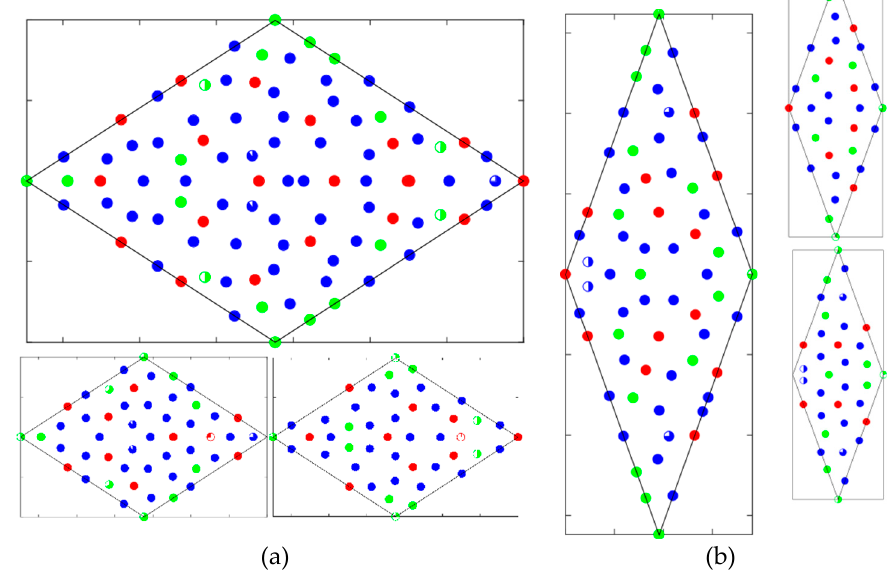
Figure 3. Decorations of structure units in the refined structure: ( a ) thick rhomb and ( b ) thin rhomb. Pairs of smaller rhombs represent decoration of unit tiles in different aperiodic planes along z -axis. Projections of decorated rhombs along z -axis are shown as large rhombs. Al atoms are marked with blue, Cu atoms with green and Rh atoms in red.